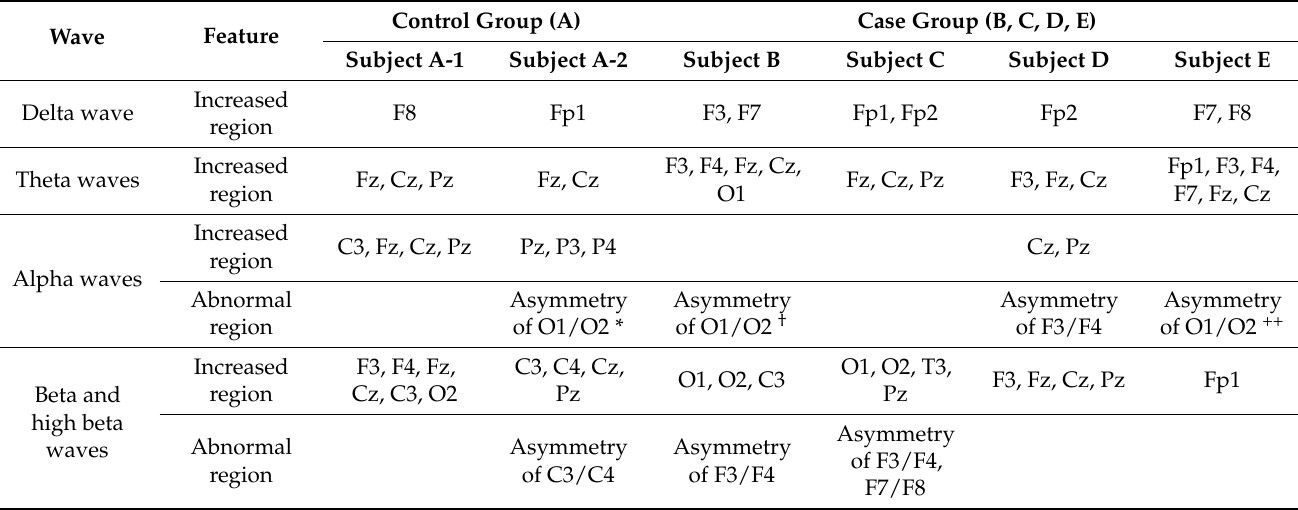
Table 5. Summary of EEG findings by wave